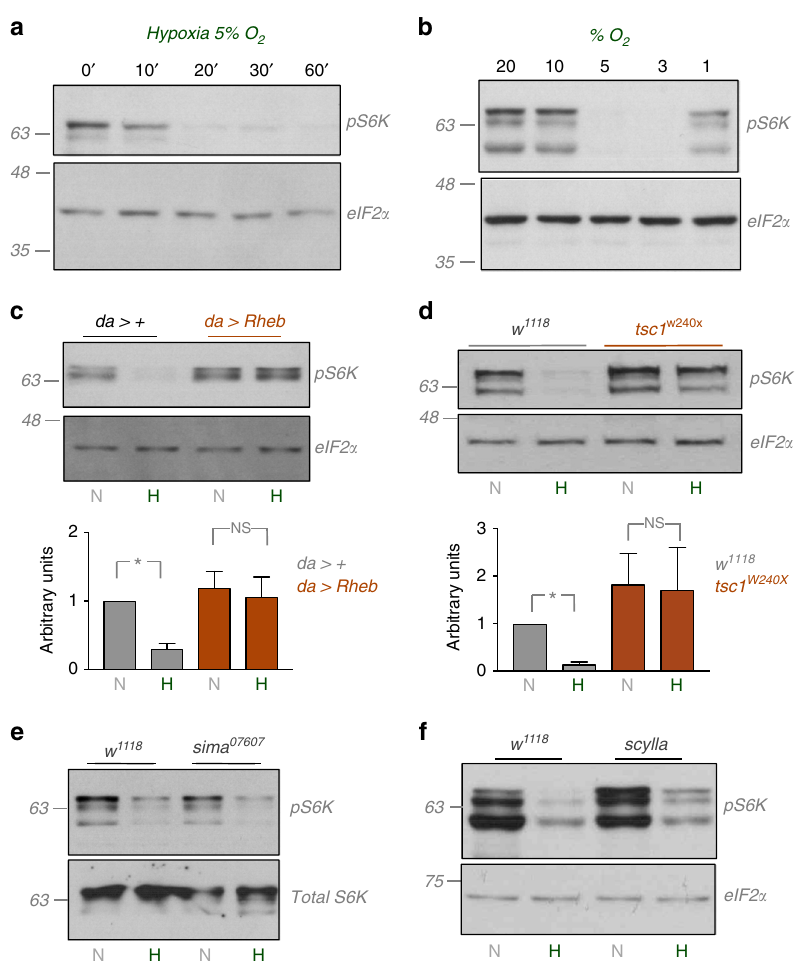
Fig. 2 Hypoxia suppresses TORC1 signalling via TSC1/2. a Early third instar larvae were transferred from normoxia to hypoxia (5% oxygen). At the indicated times, larvae were then collected, lysed and processed for SDS-PAGE and western blotting using antibodies to phospho-S6K (pS6K) or total eIF2alpha (eIF2 α ). b Early third instar larvae were transferred from normoxia to different levels of hypoxia (20 – 1% oxygen) for 1 h. Larvae were then collected, lysed and processed for SDS-PAGE and western blotting using antibodies to phospho-S6K (pS6K) or total eIF2alpha (eIF2 α ). c Control ( da > + ) or Rheb overexpressing ( da > Rheb ) early third instar larvae were either maintained in normoxia (N) or transferred from normoxia to hypoxia (5% oxygen,